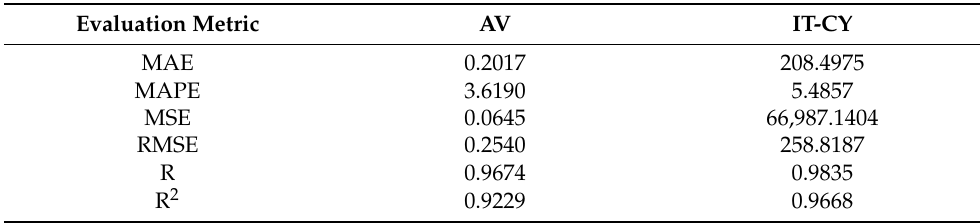
Table 4. CatBoost model testing evaluation